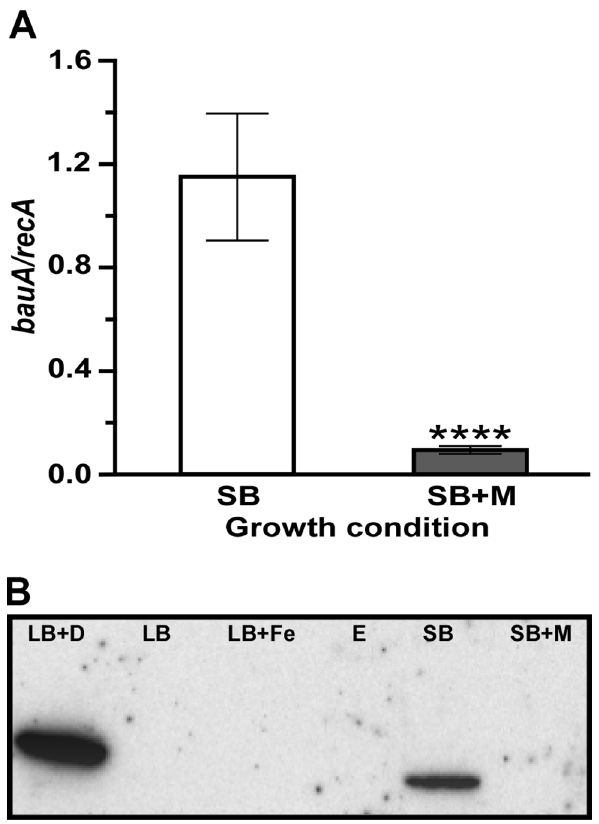
Fig 5. Differential expression of bauA in response to the presenceof mucin. (A) qRT-PCR analysisof bauA in bacterial cells culturedin SB (white bar) or SB+M (grey bar) performed using nine replicates. Significantly different values ( P (cid:20) 0.0001)are identified by four asterisks and error bars represent the standarderror of each data set. (B) Western blot of whole-cell lysate proteins obtained from ATCC 19606 T bacterial cells grown in LB (LB), LB supplemented with 100 μ M dipyridyl(LB+D) or 100 μ M FeCl 3 (LB+Fe), SB, or SB+M. E, empty lane. SDS-PAGE size-fractionated proteins were blotted onto nitrocellulose and probedwith anti-BauApolyclonal antibodies.The western blot shown in this panel is a representativeimage of three blots obtainedwith three independentbiological samples preparedas describedabove. All three blots produced the same